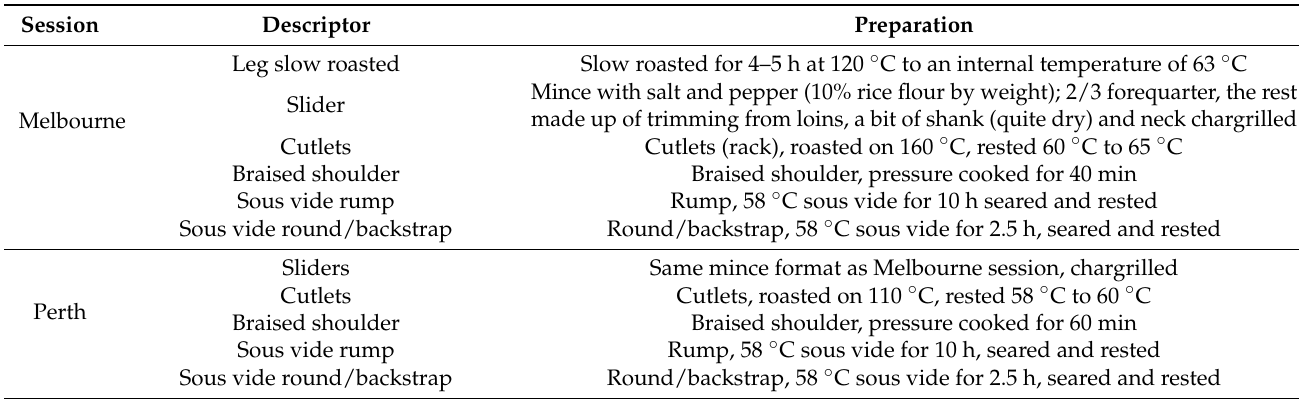
Table 3. Dry aged mutton carcass and dish preparation for perceptual mapping